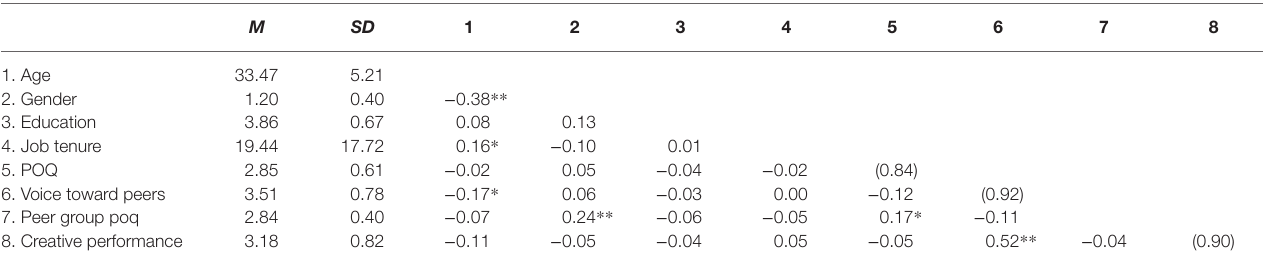
TABLE 2 | Means, standard deviations, correlations, and internal consistency coefficient. M